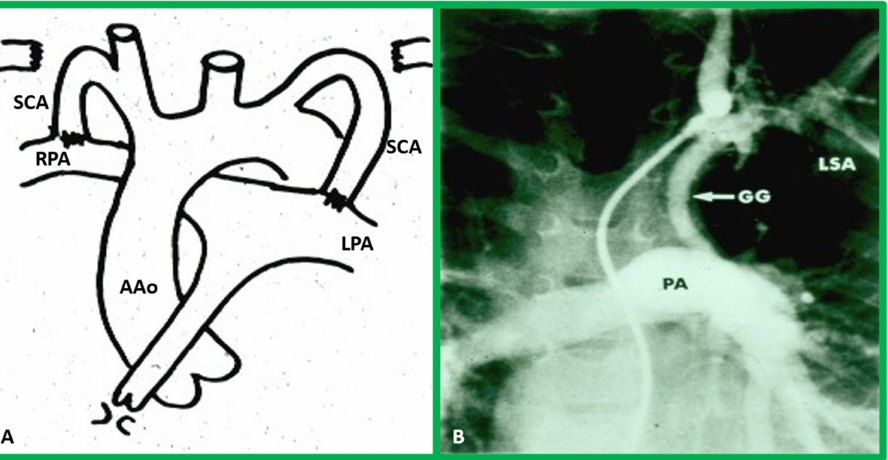
Figure 7. ( A ) Hand drawing (drawn by Dr. Taussig herself) illustrating the concept of the Blalock– Taussig shunt [25] showing the anastomosis of the subclavian arteries (SCAs) to the left (LPA) or right (RPA) pulmonary arteries, respectively. ( B ) Selected frame from a cine-angiogram of the Gore-Tex graft (GG) showing modified Blalock–Taussig (BT) shunts [18]. This image demonstrates widely patent BT shunt and excellent visualization of the pulmonary artery (PA). AAo, ascending aorta; LSA, left subclavian